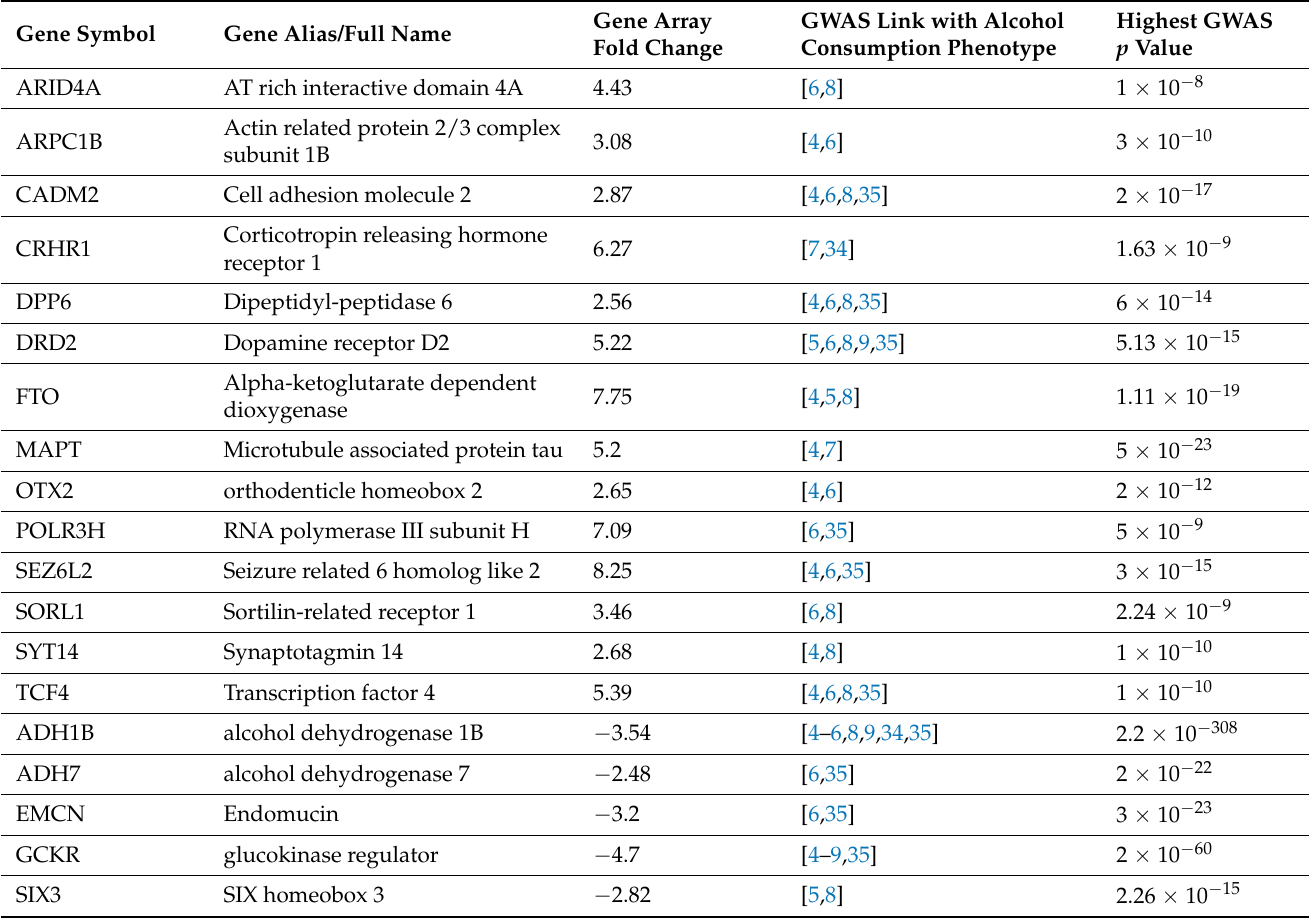
Table 1. 16 genes that were differentially expressed (FDR p < 0.05) in the dorsomedial thalamus of AUD subjects and have also been found to be significantly (FDR p < 10 − 8 ) associated with AUD or alcohol consumption phenotypes in at least two independent recent GWAS studies (2019–2000: Evangelou et al., 2019 [4]; Liu et al., 2019 [6]; Sanchez-Roige et al., 2019 [7]; Zhou et al., 2020 [8]; Thompson et al., 2020 [9]; Gelernter et al., 2019 [34]; Karlsson et al., 2019 [35]). The highest GWAS p -value has been given. More detailed information about GWAS phenotypes and p -values can be found in Supplementary Table